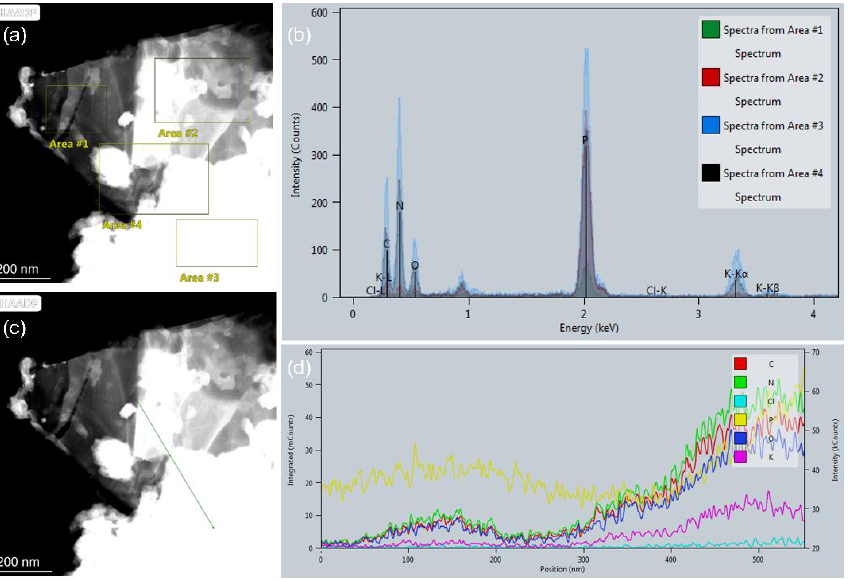
Figure 3. ( a , c ) TEM image of 10%BP/KPHI; ( b ) EDS image of 10%BP/KPHI; ( d ) Line scanning profile of 10%BP/KPHI catalyst.